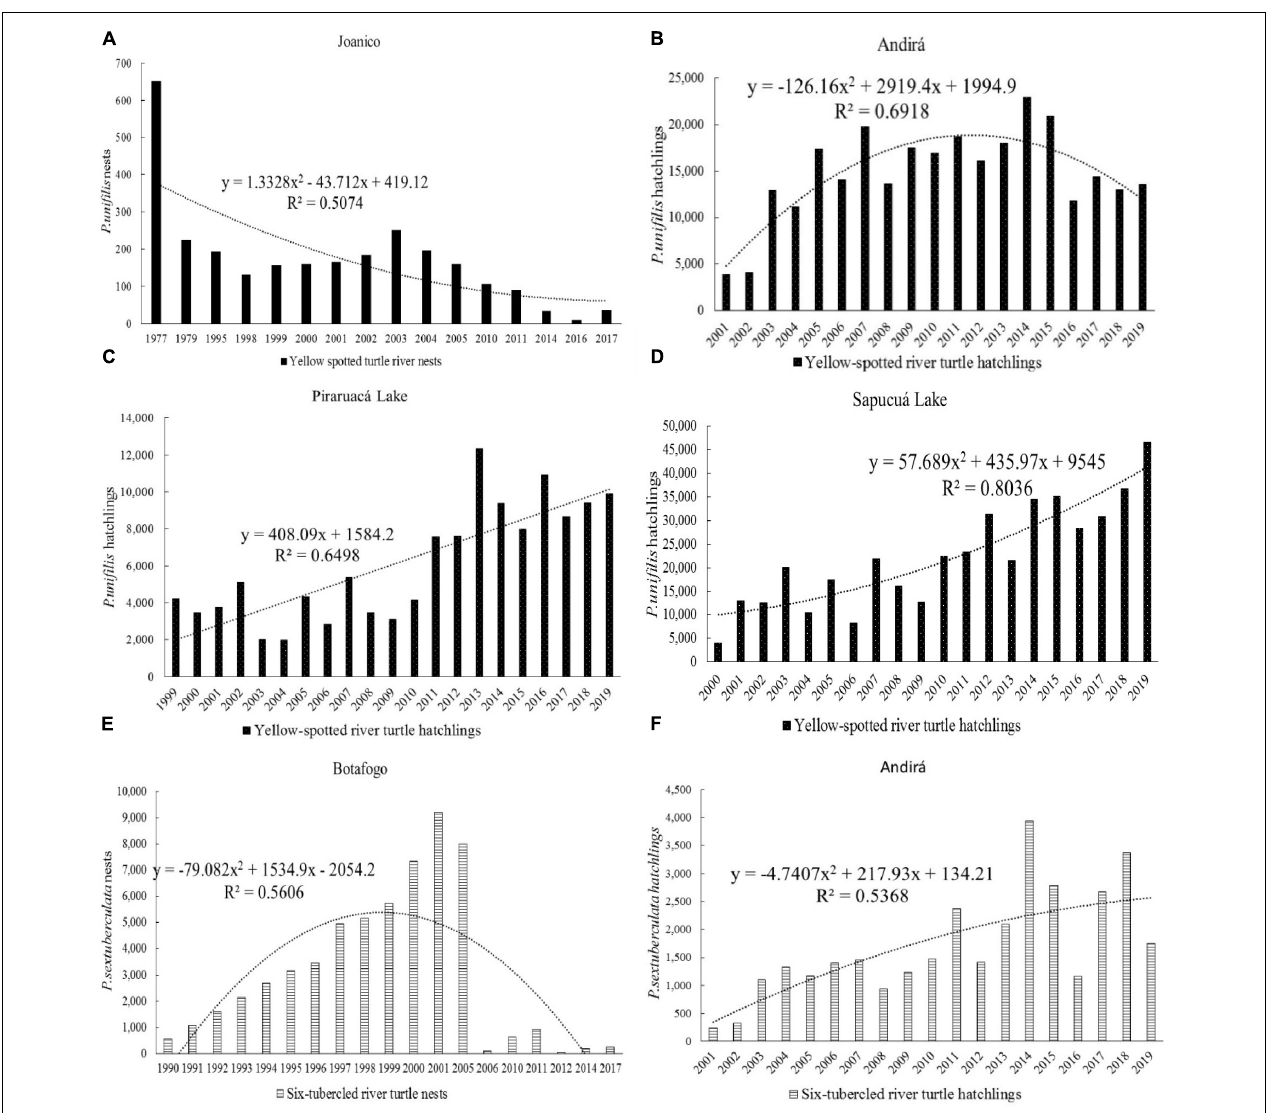
FIGURE 9 | Time series for the production of P. unifilis and P. sextuberculata nests and hatchlings at different nesting sites: P. unifilis : (A) Nests in the Joanico, Juruá River; (B) Hatchlings in the Andirá River; (C) Hatchlings in the Piraruacá Lake; (D) Hatchlings in the Sapucuá Lake; P. sextuberculata : (E) Hatchlings in the Botafogo, Juruá River; (F) Hatchlings in the Andirá